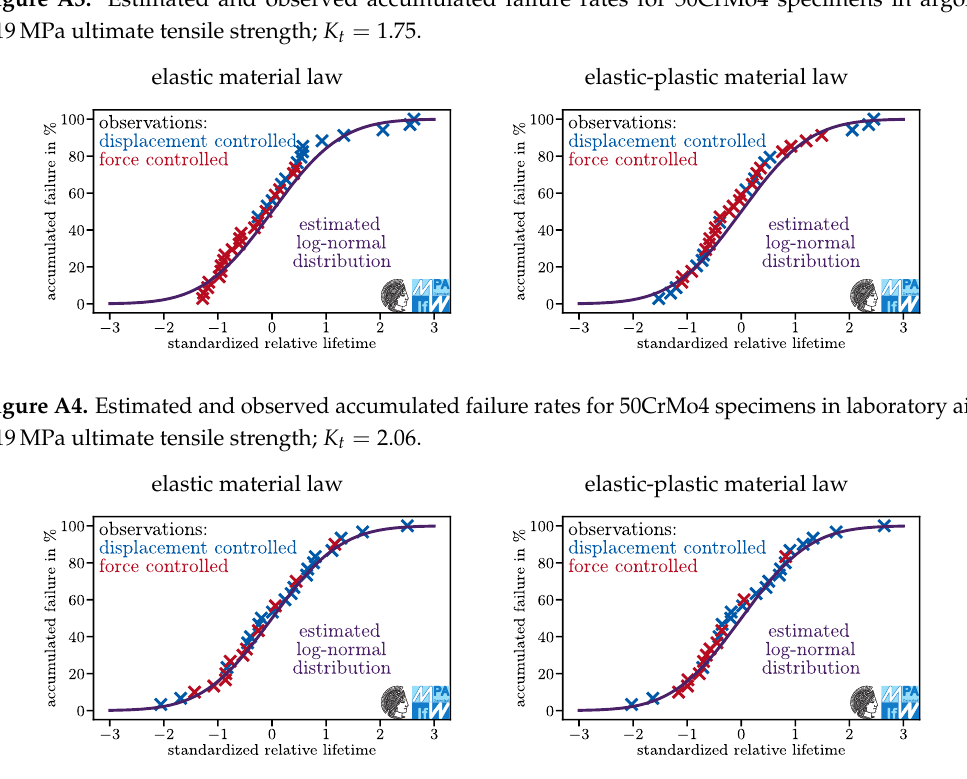
Figure A5. Estimated and observed accumulated failure rates for 50CrMo4 specimens in laboratory air; 1096MPa ultimate tensile strength; K t =